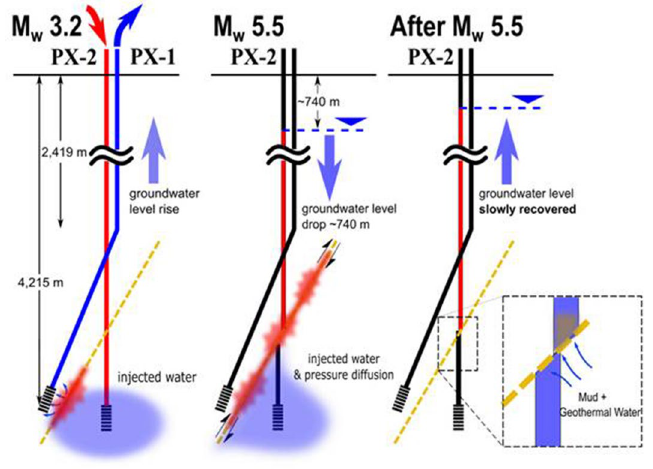
Figure 9. Schematic illustration of groundwater level changes after the M W 3.2 and M W 5.5